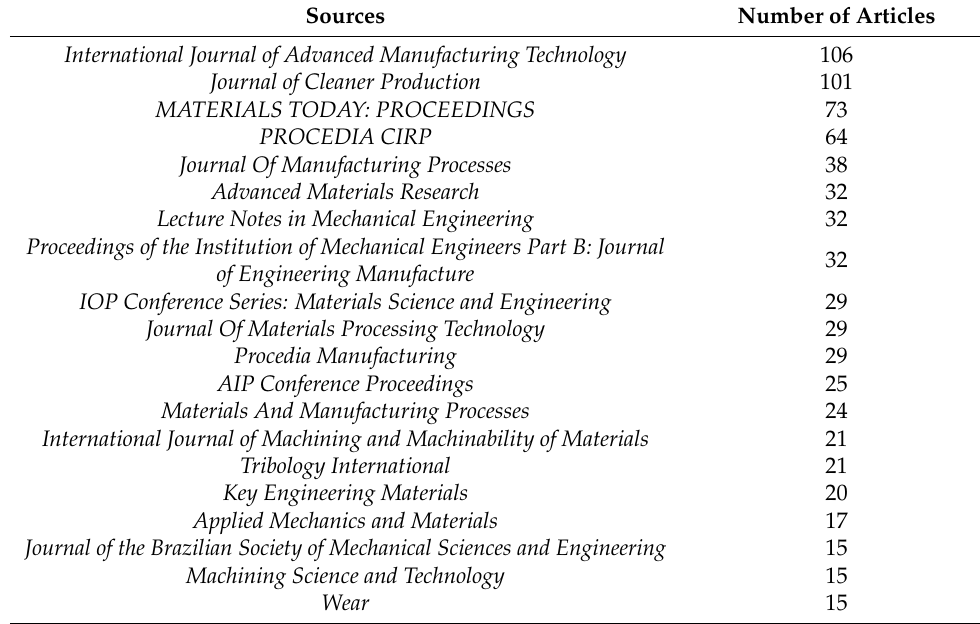
Table 1. Most relevant sources and their number of published articles.